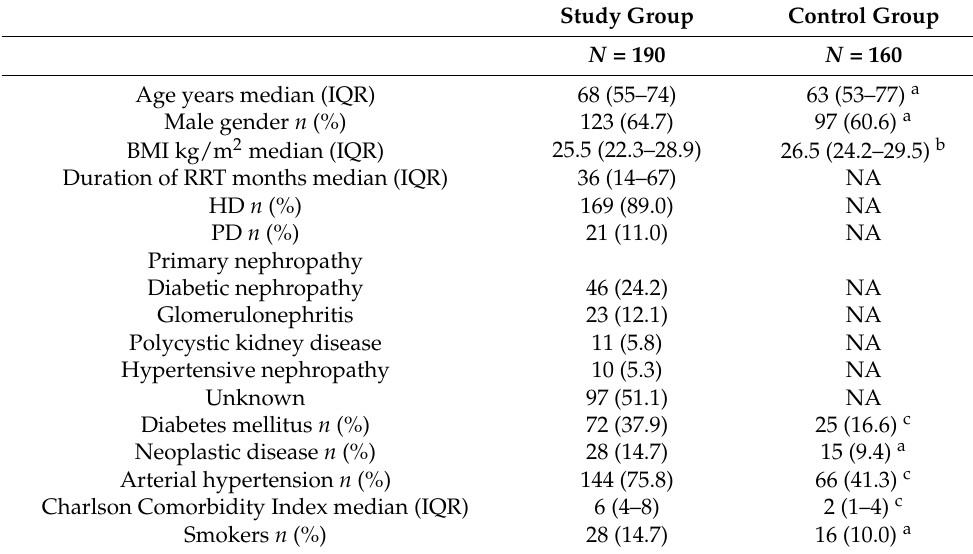
Table 1. Characteristics of the study and the control group.